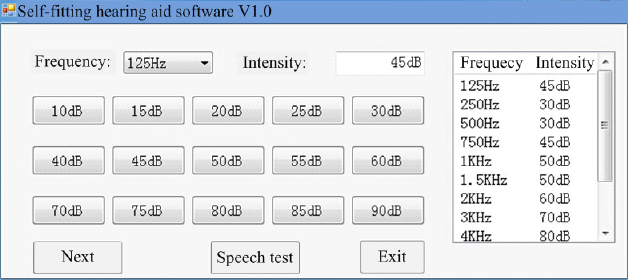
Figure 6. Interface for the pure tone test.